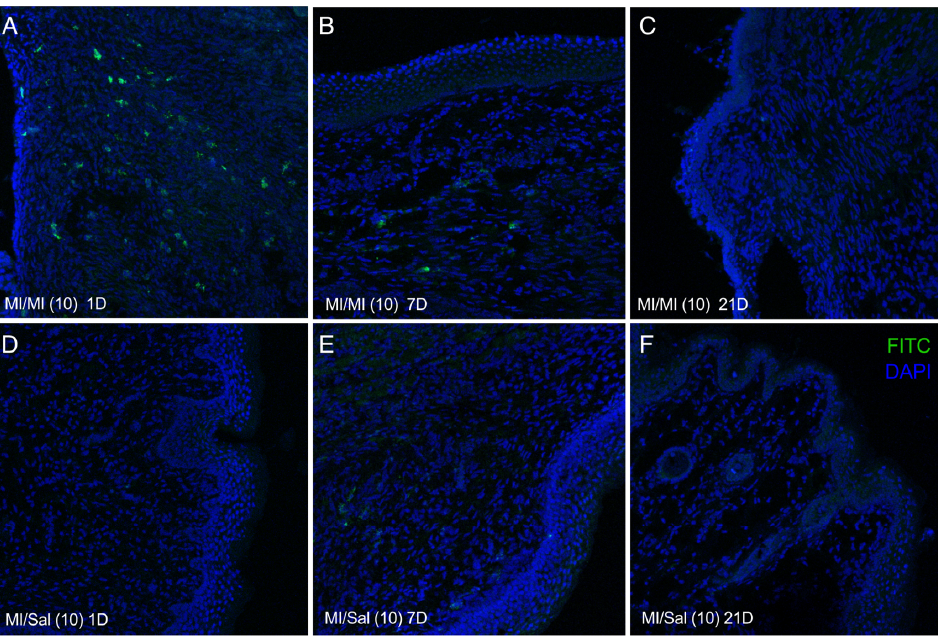
Figure 3. Increased mast cell density in the vaginal canal and elevated tactile ano-genital sensitivity after 10 intra-vaginal MI challenges in previously sensitized ND4 female mice. Representative confocal images of vaginal canal tissue from MI sensitized mice challenged with MI ( A – C ) or saline D – F ) at 1, 7, and 21 days after the 10th MI challenge, respectively. Mast cells stained with FITC- conjugated avidin (green) and nuclei counterstained with DAPI (blue); 200× magnification. ( G ) Density of avidin + mast cells in 12 μm vaginal canal cryo-sections from sensitized mice challenged with MI or saline. Results reported as fold change in avidin signal in MI- over saline-treated mice. Dotted line denotes no change. Data pooled from 5–6 mice. ( H ) Serum IgE content in mice treated with MI or saline in the vaginal canal 1 day after the last MI/saline challenge. NT bar denotes serum